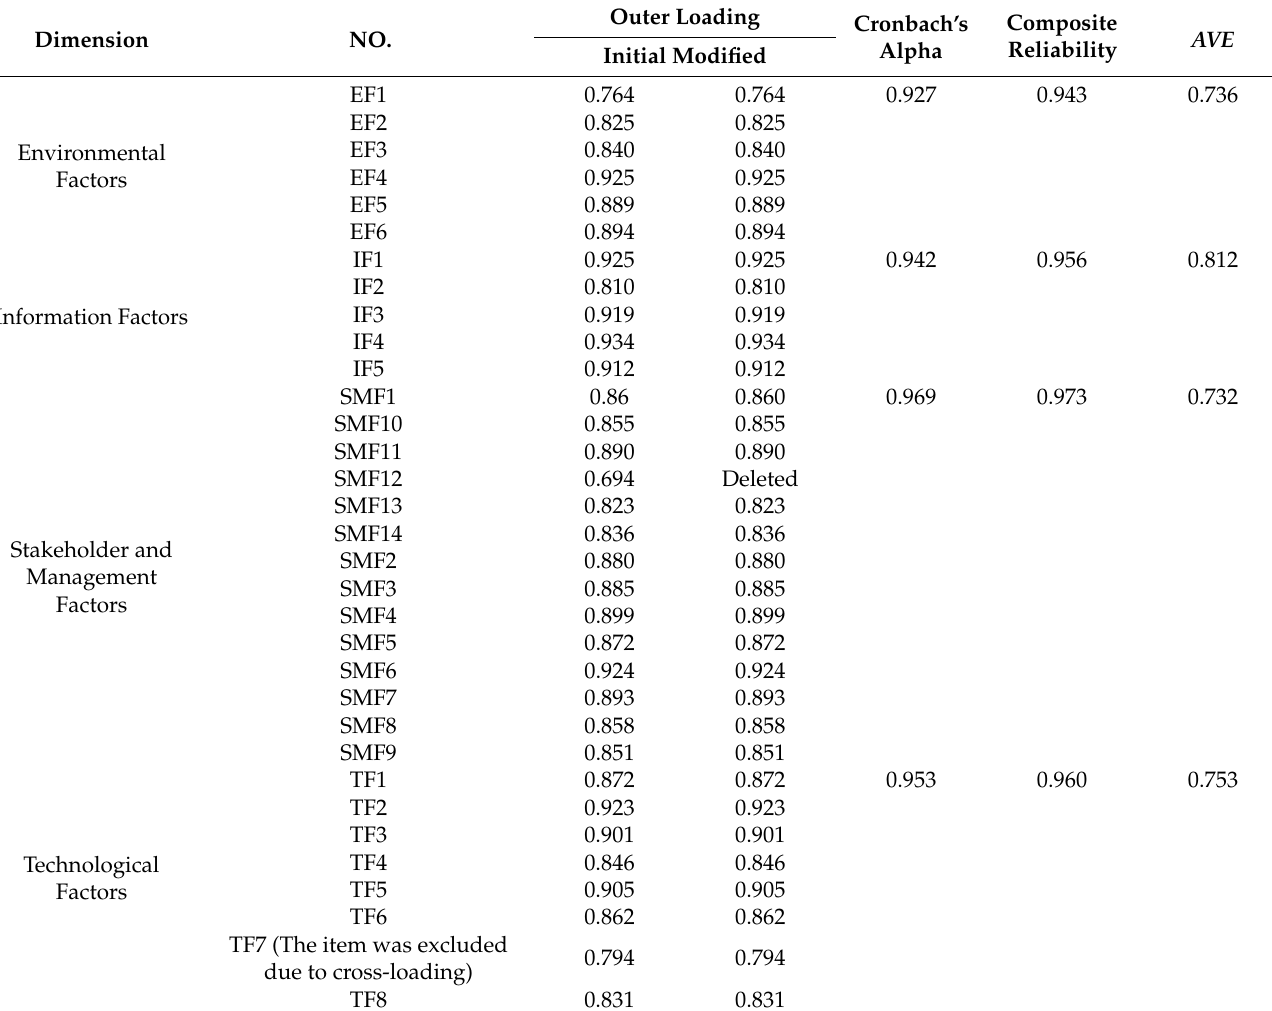
Table 6. Reliability